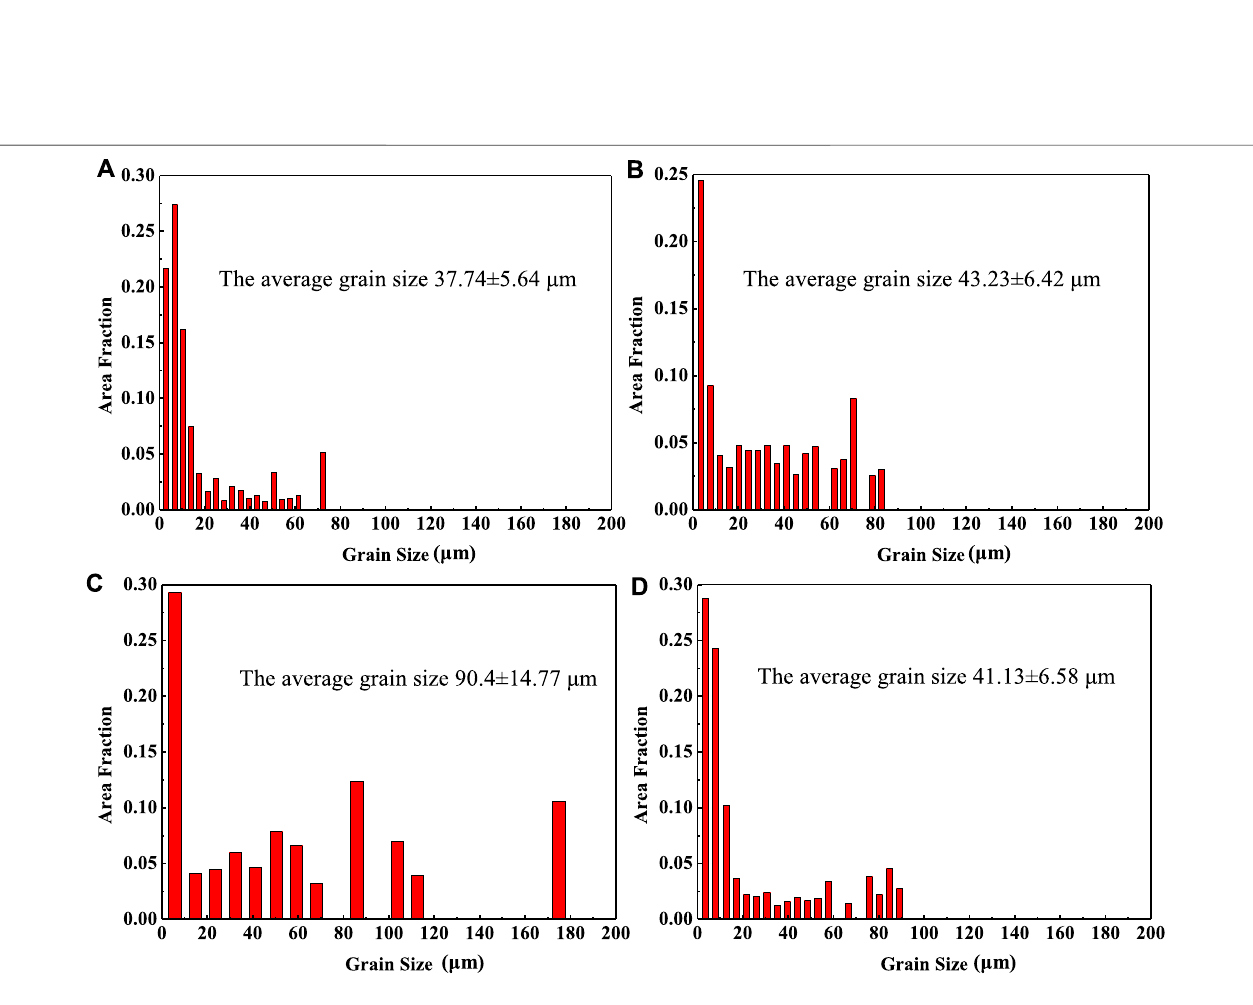
FIGURE 9 | Grain size distributions of the Co – Ni – Cr – W – based superalloy deformed at different strain rates with the temperature of 1,100 ° C: (A) 0.01 s − 1 , (B) 0.1 s − 1 , (C) 1 s − 1 , and (D) 10 s − 1 .